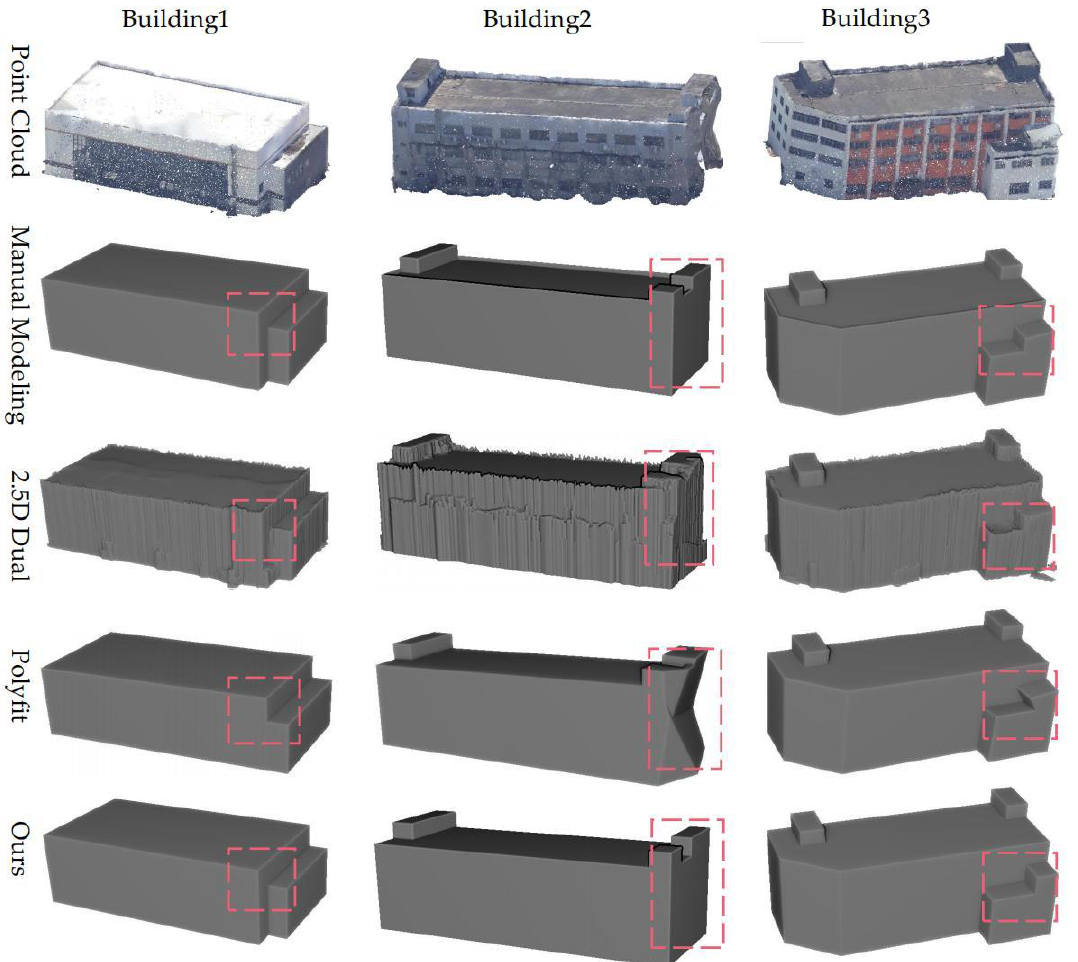
Figure 12. Comparison of models generated using the manual modeling, the 2.5D DC method, the PolyFit method, and our proposed method for Buildings 1, 2, and 3.